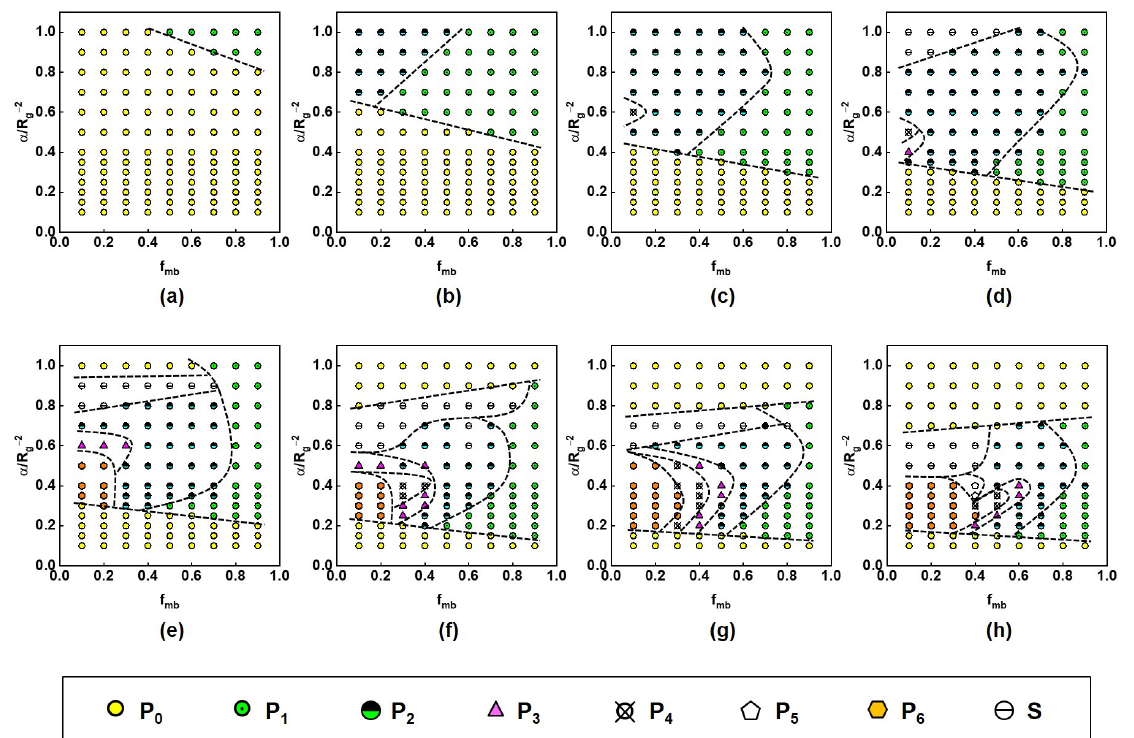
Figure 2. Morphological diagrams in the space of the grafting density α versus the fraction f mb of mobile brushes for nanoparticles with the radii of ( a ) 0.4 R g , ( b ) 0.6 R g , ( c ) 0.8 R g , ( d ) 1.0 R g , ( e ) 1.2 R g , ( f ) 1.4 R g , ( g ) 1.6 R g , and ( h ) 1.8 R g .